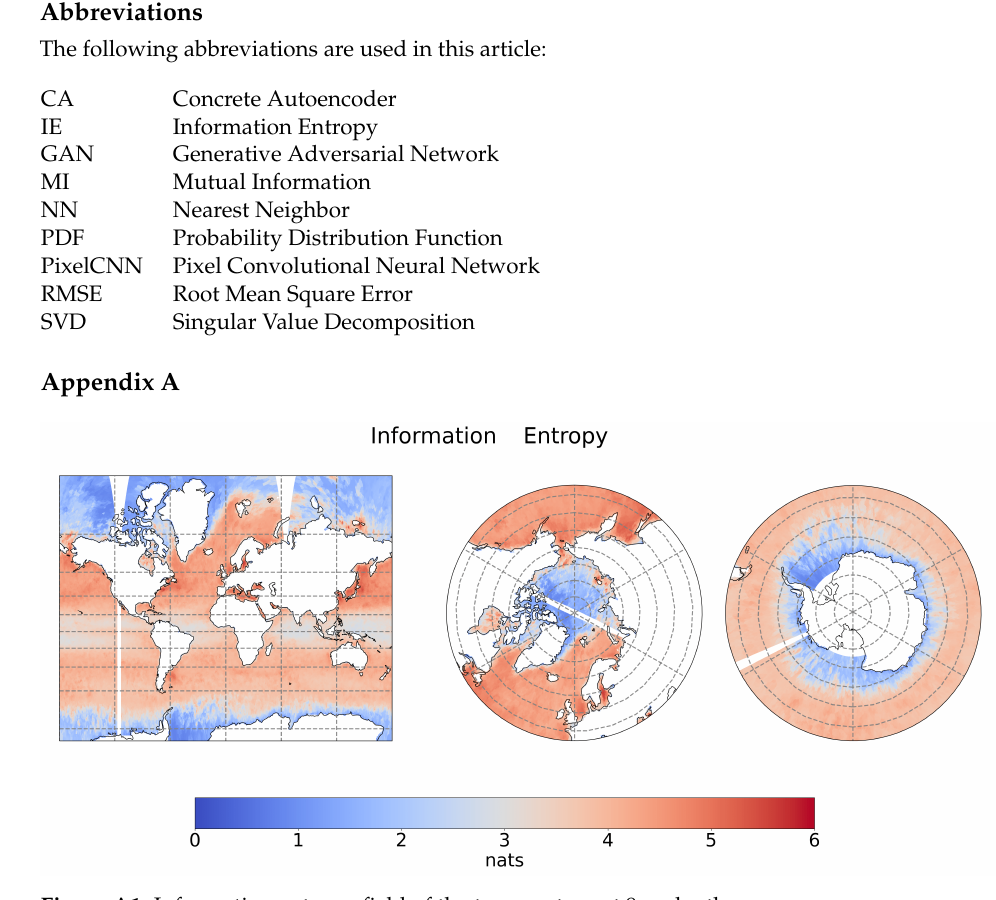
Figure A1. Information entropy field of the temperature at 9 m